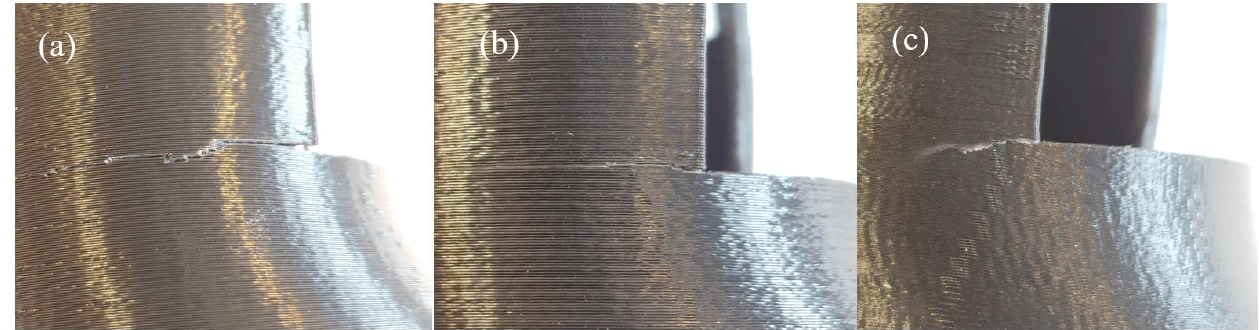
Figure 21. Fractures of tested VEL sockets of PLA. ( a ) Econo: large, multiple layers. ( b ) Strong: medium, single layer. ( c ) Accura: small, multiple layers.